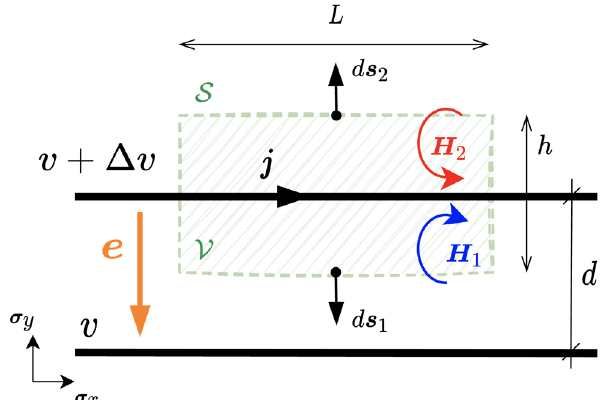
Figure 1. Relevant variables for the computation of magnetic and electric fields for two long parallel wires. Only the current on the top cable has been considered. The orientation for e and H follows positive values of the